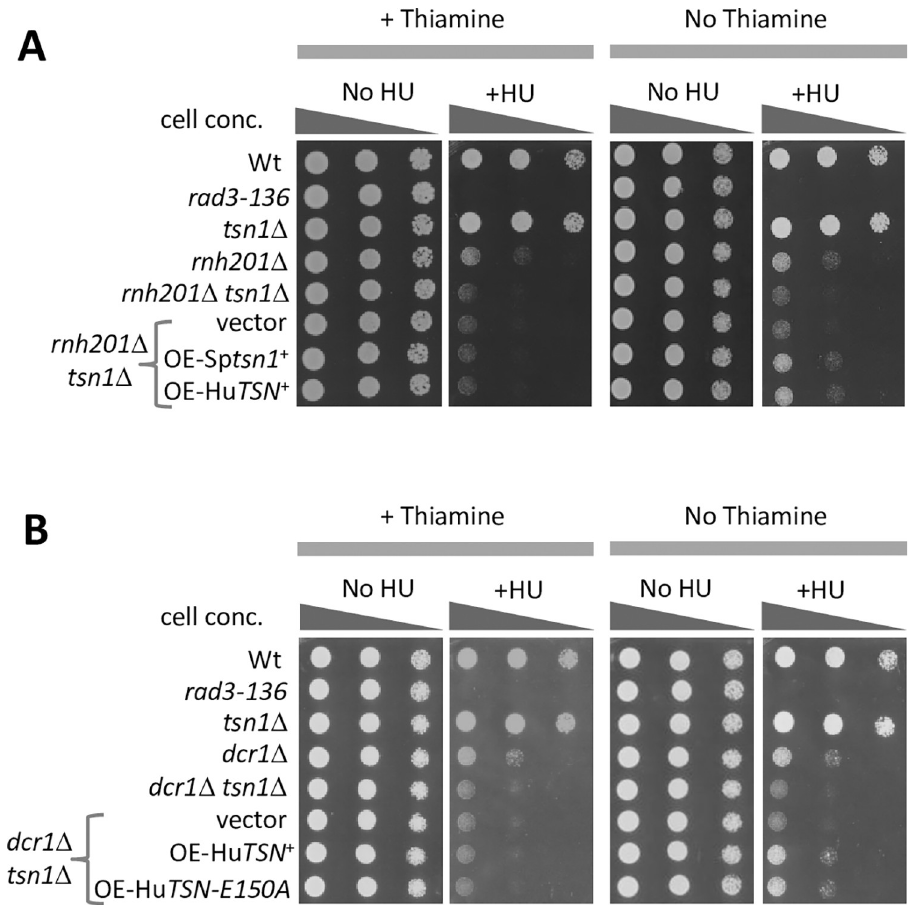
Fig 5. Human TSN functions to suppress the requirement for S . pombe tsn1 + in genome stability maintenance. (A) 10-fold serial dilutions of indicated strains were spotted onto EMM with thiamine (with and without HU; 10 mM) or without thiamine (with or without HU;10 mM). OE-Sp tsn+ —overexpressed S . pombe tsn1 + ; OE-Hu TSN + — overexpressed human TSN + . (B) 10-fold serial dilutions of indicated strains were spotted onto EMM with thiamine (with and without HU; 10 mM) or without thiamine (with or without HU;10 mM). OE-Hu TSN + —overexpressed human TSN + ; OE-Hu TSN-E150A – overexpression of human TSN + mutated at sole the residue conserved with the TSNAX (and Tfx1) RNase catalytic